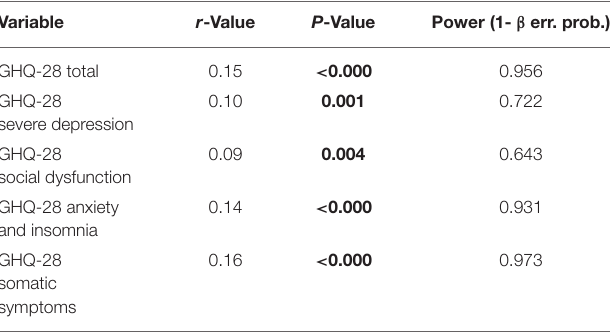
TABLE 1 | General characteristics of the study sample. TABLE 2 | Correlations of the total number of points obtained in the COVID-19 knowledge questionnaire and the severity of psychopathological symptoms.